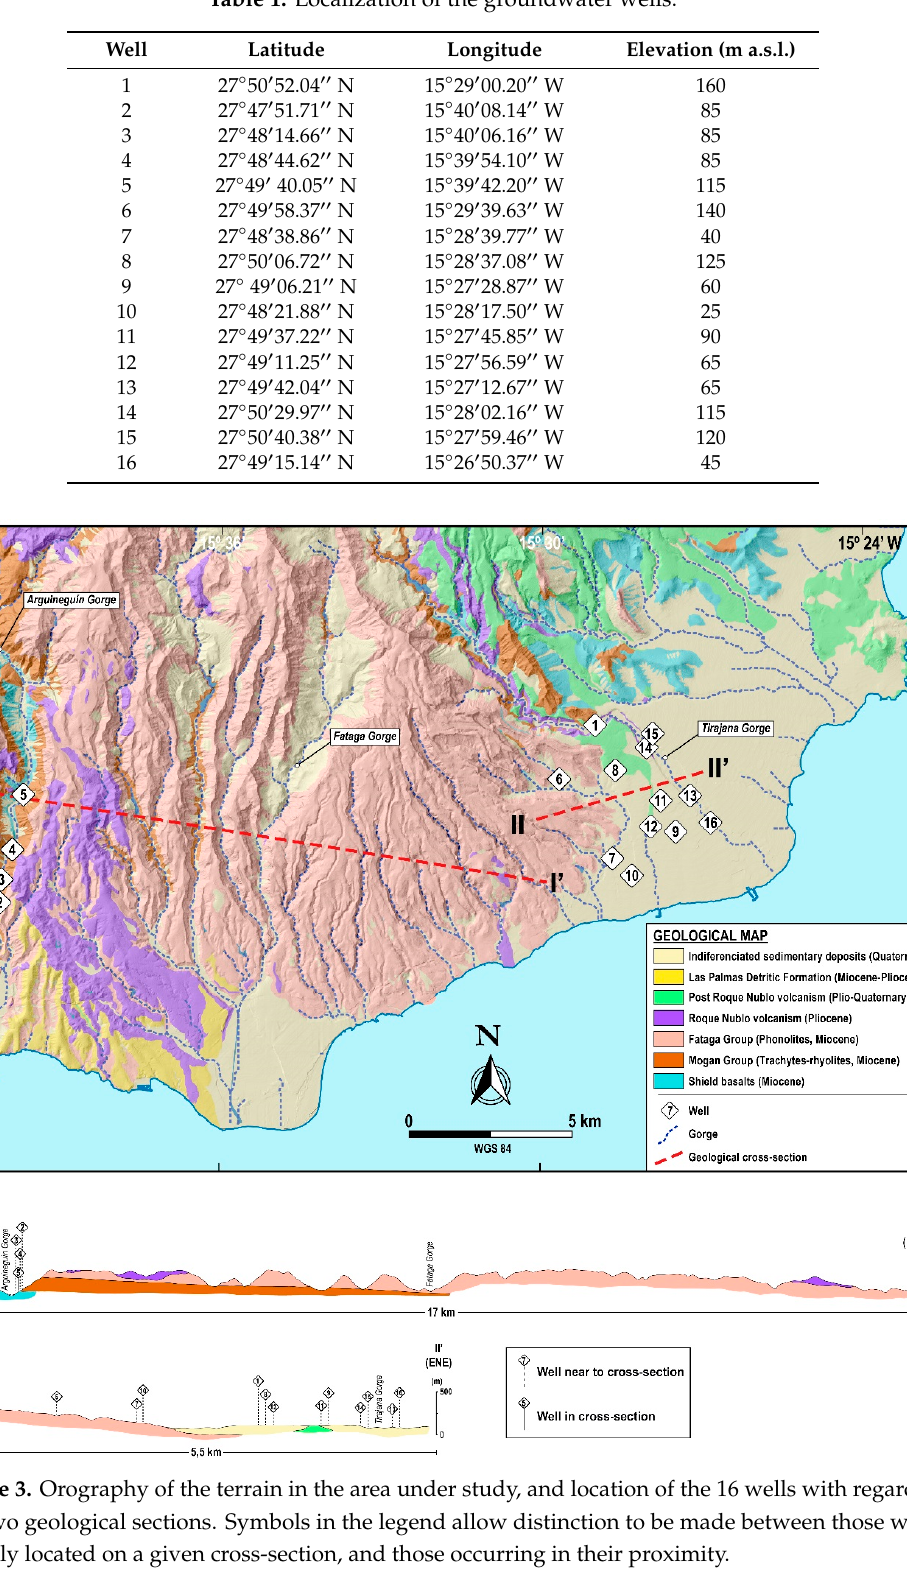
Table 1. Localization of the groundwater wells.